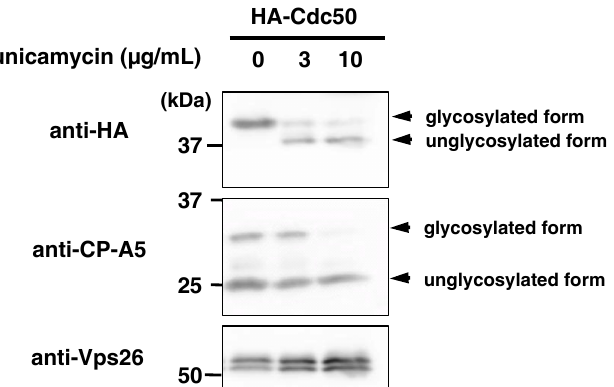
Figure 2. Demonstration of N -linked glycosylation on EhCdc50. HA-EhCdc50 expressing cells were treated with tunicamycin at 1, 3, 10 µg/mL for 24 h. Cells were lysed and analyzed by immunoblotting with anti-HA, anti-EhCP-A5 and anti-EhVps26 antibodies. The apparent molecular weight of HA-EhCdc50 was decreased by the tunicamycin treatment. EhCP-A5 and EhVps26 are the glycosylated and non-glycosylated proteins, respectively.